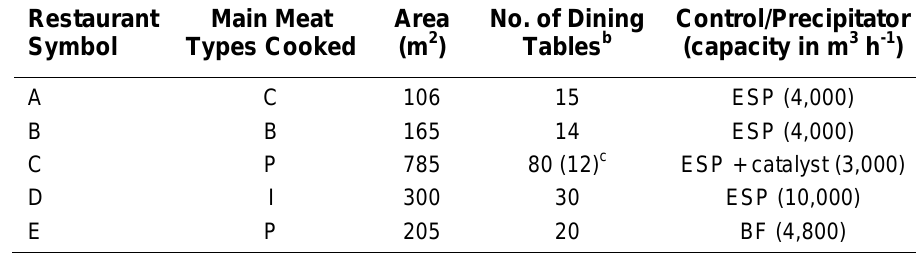
Five Restaurants Investigated in this Study a